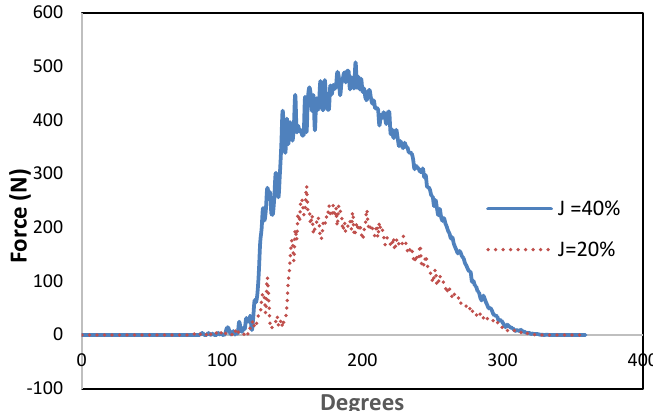
Figure 11. Average radial forces acting on the shell liner forces for mill filling at 20% and 40%.